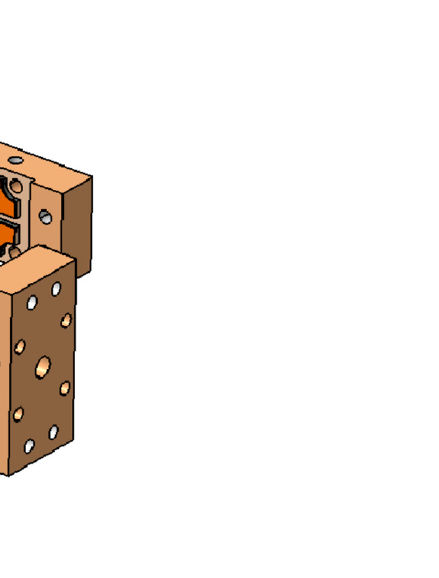
Figure 10. Core of MicroSTAR with the cubic PM surrounded by 6 identical electrode plates.